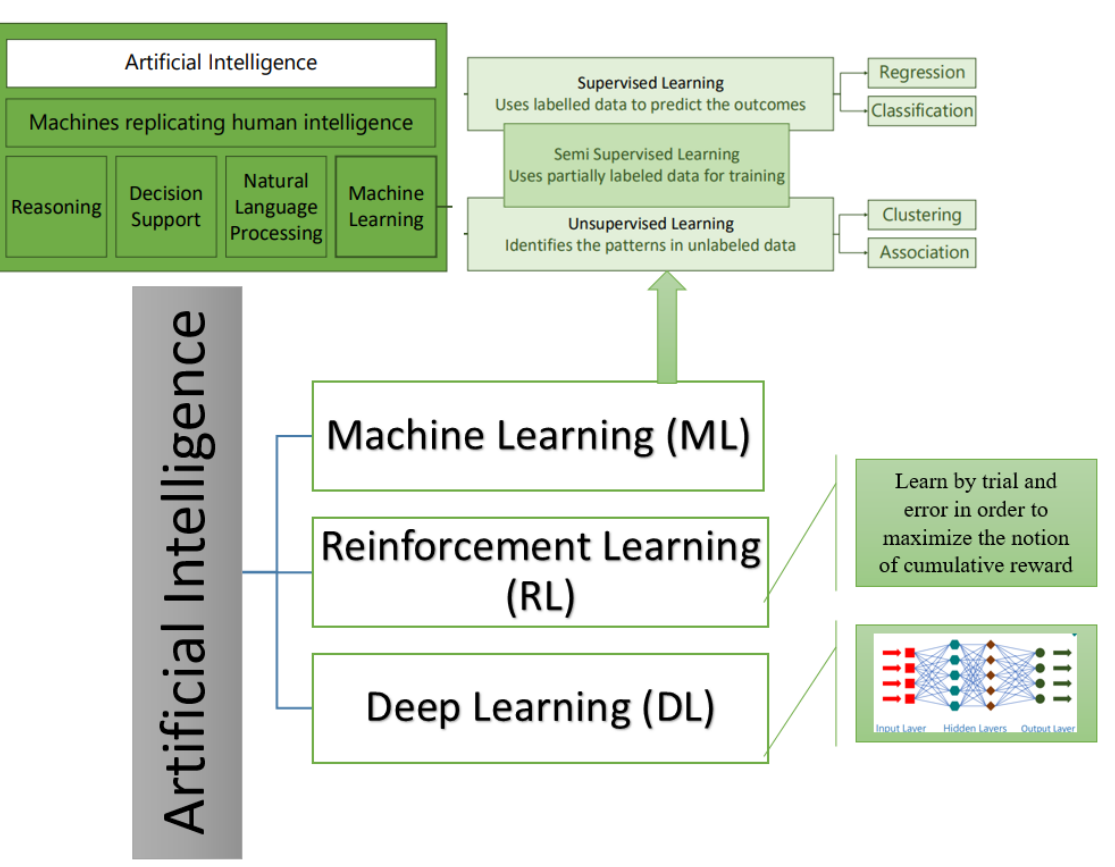
Figure 3. A depiction of AI, ML, RL, and DL methods used in healthcare systems.